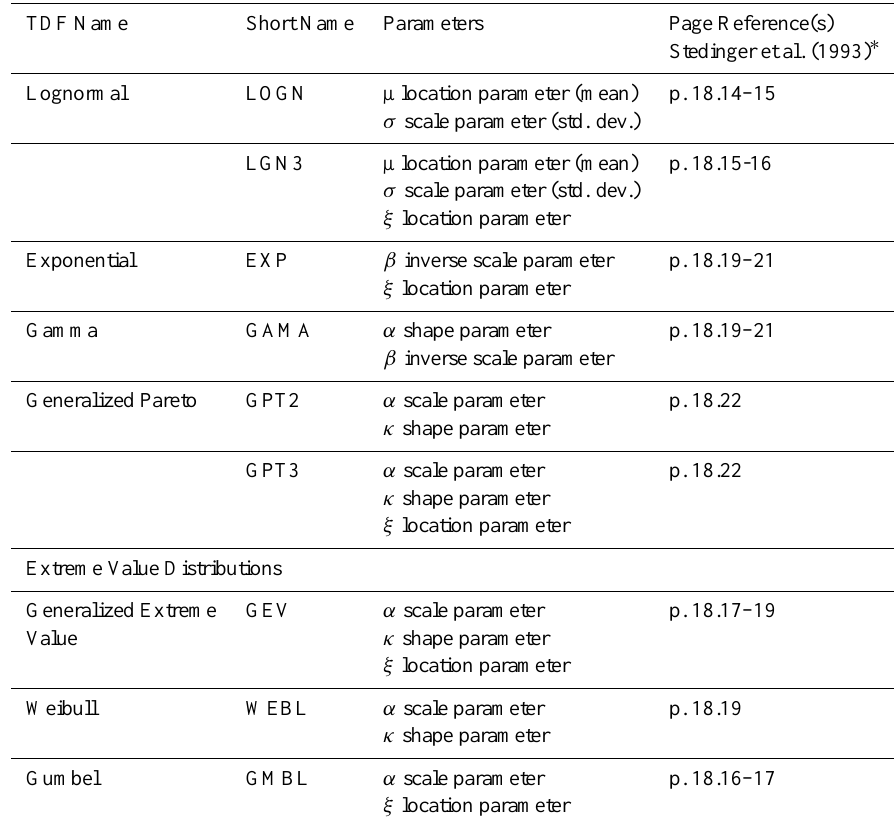
Table 3. Theoretical Distribution Functions tested for skill in fitting the CDF of within-day rainfall intensity. This table also indicates the short name assigned to each TDF, lists the parameters of the distribution and their function (scale, shape, or location), and indicates the source for relationships used in the fitting process (pages from Stedinger et al.,